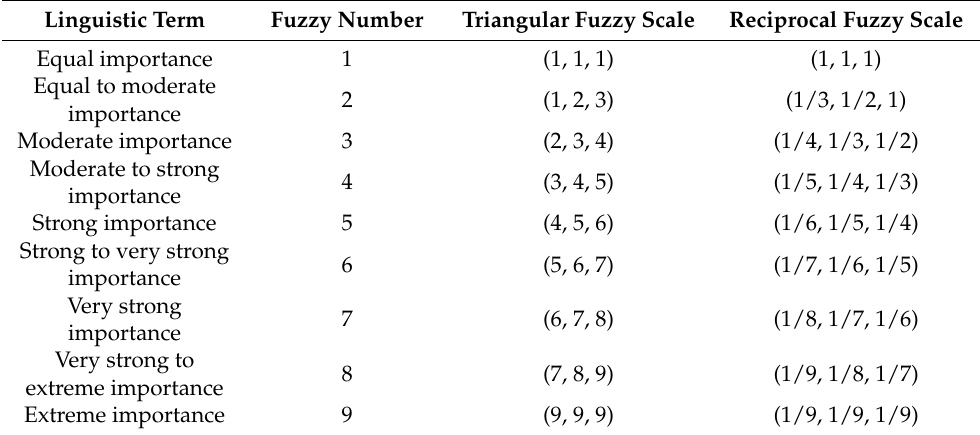
Table 3. Fuzzy scale for pairwise